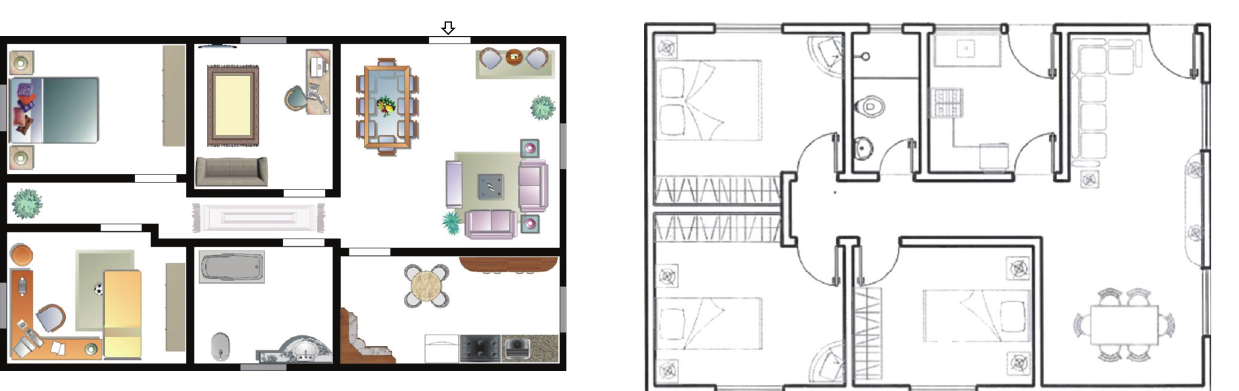
Figure 14: Our floor plan and included furnitures.